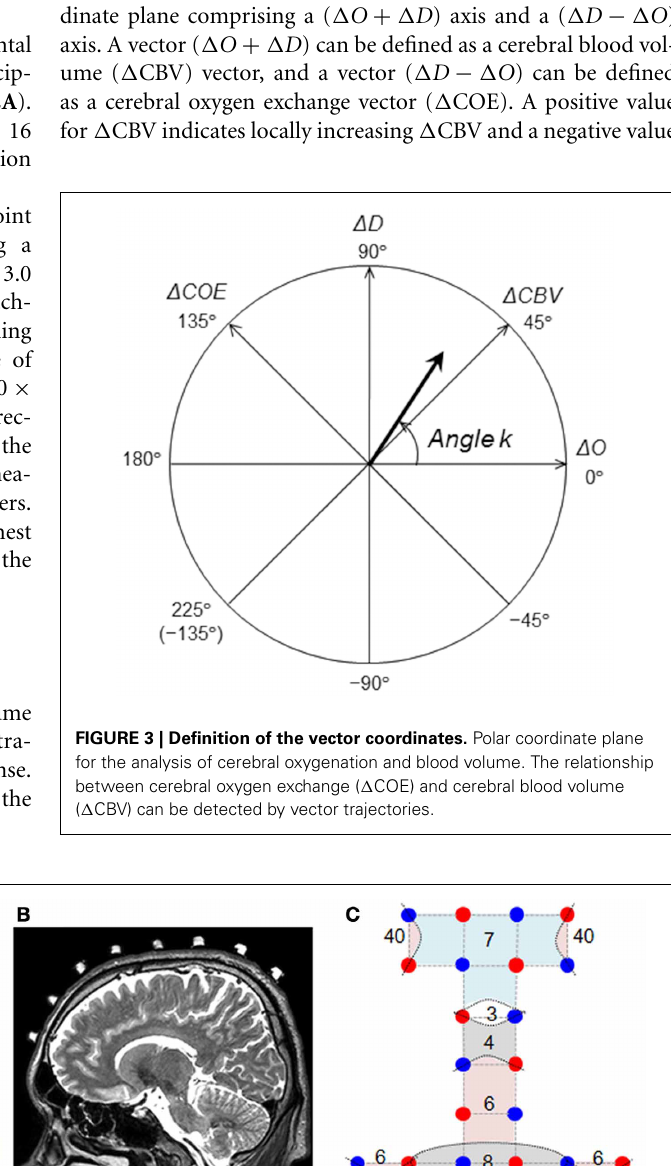
schematic boundaries of the Brodmann areas that were confirmed by MRI. Straight lines connecting the emitters and detectors indicate channel